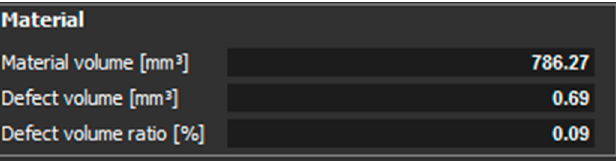
Figure 7. Evaluated values for a sample with a thickness of 1 mm, which is oriented in Z.